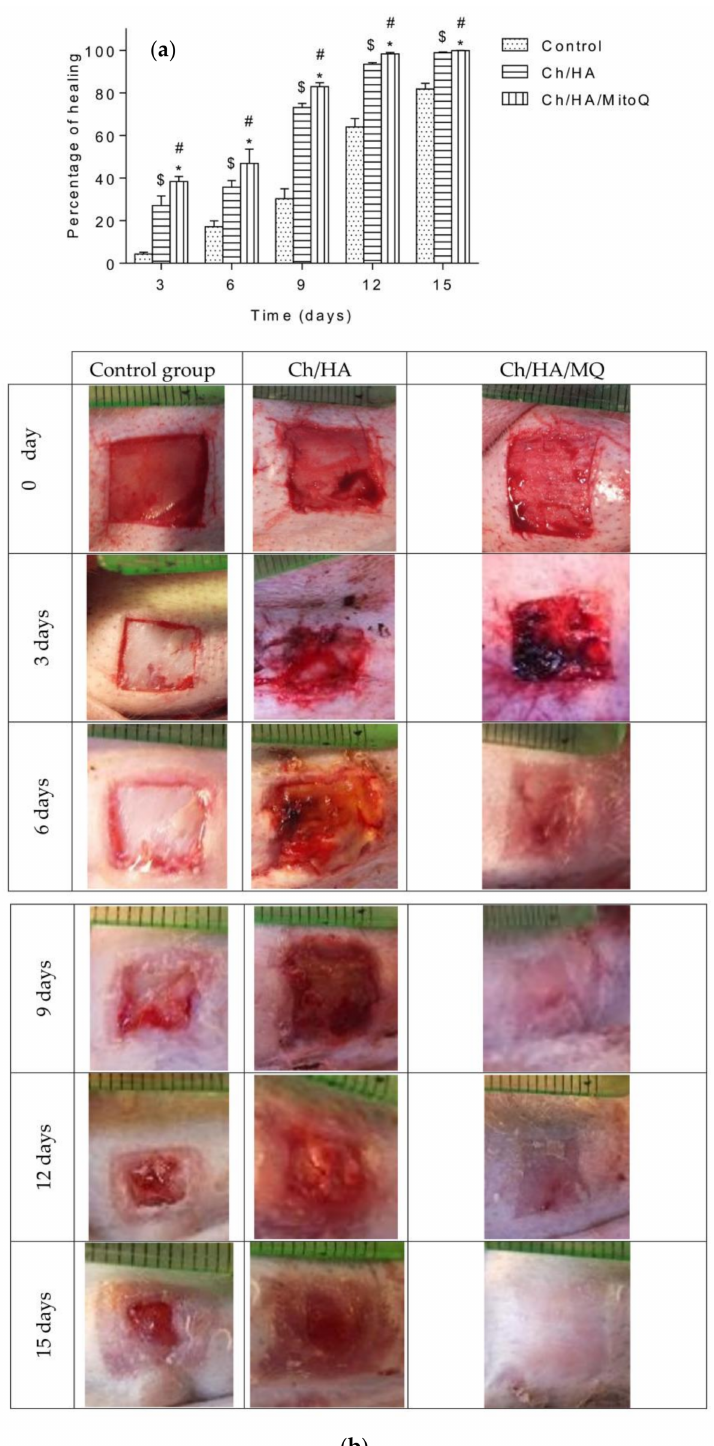
Figure 3. Profiles of the wound closures in rabbits, when the wound was not treated (control), the wound treated with the Ch/HA membrane and the Ch/HA/MitoQ membrane. The asterisk (*) indicates a significant difference at p ≤ 0.05 between the control and Ch/HA/MitoQ. The mark ( # ) indicates a significant difference between the Ch/HA and Ch/HA/MitoQ membranes at p ≤ 0.05. The mark ( $ ) indicates a significant difference between the control and the Ch/HA membrane at p ≤ 0.05, n = 6 ( a , b